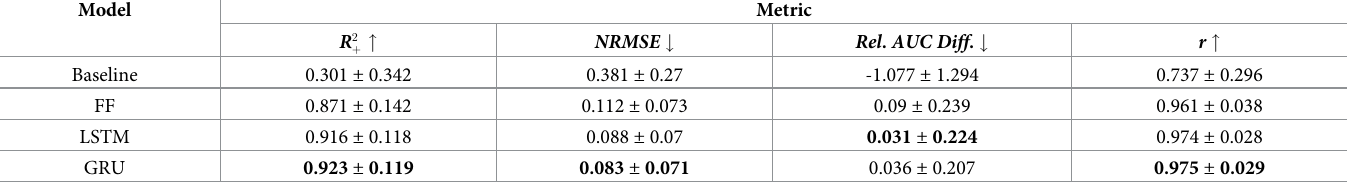
Table 3. Global fit metrics calculated for the testing subset. The arrows point in the direction of more desirable magnitudes. The entries for metric � are formatted as � � s ð�Þ where � and σ ( � ) are the mean and standard deviation calculated over all locations and years. In each column, the entry in bold has the best performing mean. See Performance metrics and S3 Appendix for a description of the